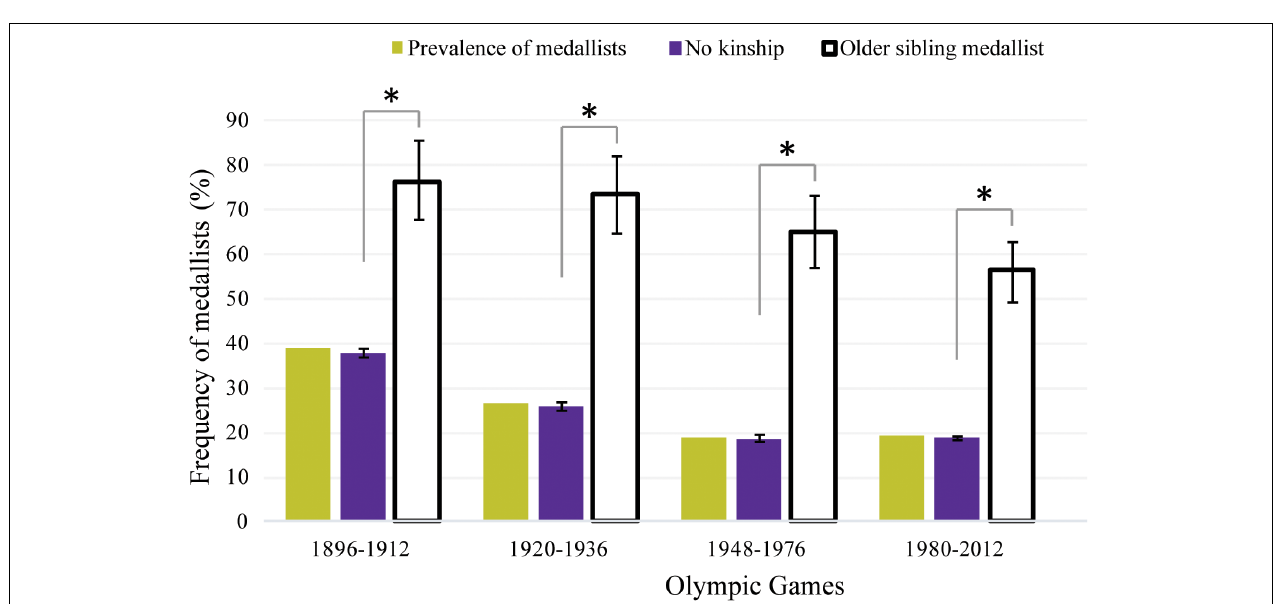
FIGURE 4 | Prevalence of Medallists in the Olympic Games according to four historical periods (yellow bars). The purple bars represent the frequency of Medallists (%) ( ± 95% CI) among Olympians with no kinship in the Games per period. The white bars represent the observed frequency of Medallists (%) ( ± 95% CI) among Olympians with a former sibling Medallist in the Olympics for each period. ∗ The Medallist frequency was significantly different ( p < 0.001) from the expected